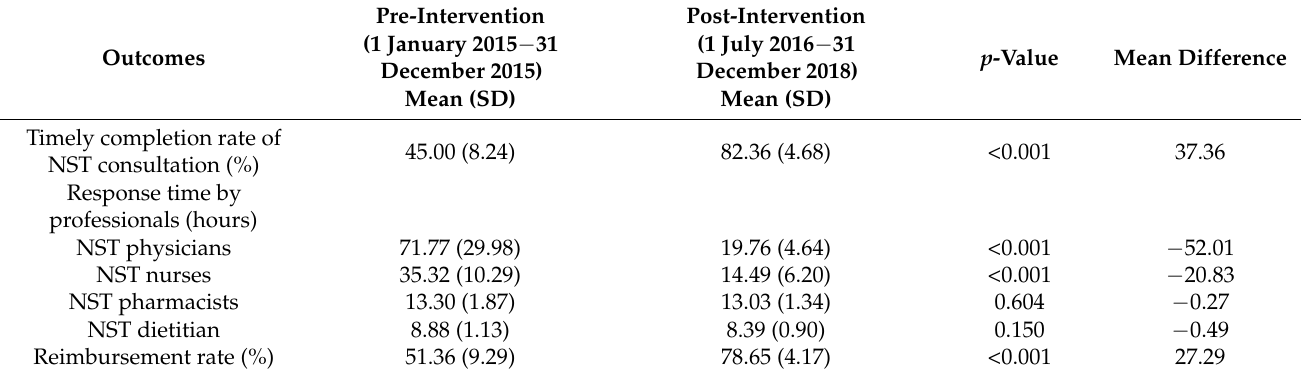
Table 1. Changes in administrative outcomes between pre- and post-intervention periods.